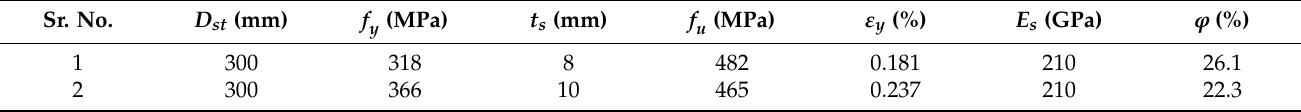
Table 3. Parameters of STT.